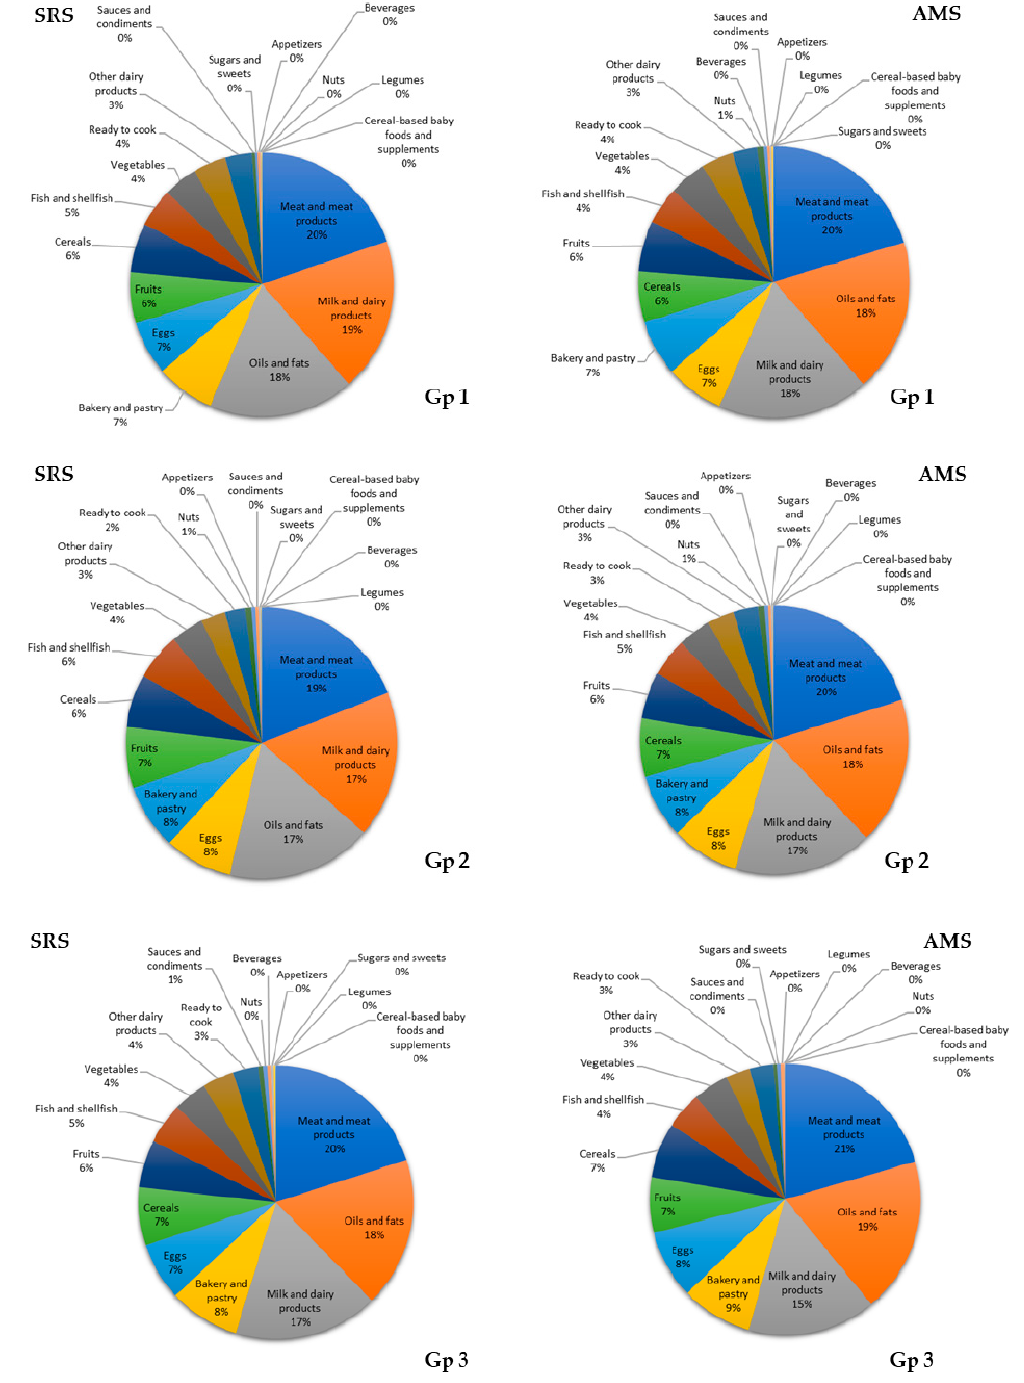
Figure 4. Contribution (%) of the 18 food groups to α -linolenic acid (ALA) intake in the EsNuPI study population (Spanish Reference Cohort (SRS) and Adapted Milk Consumers Cohort (AMS)) according to age group (( Gp 1 ), 1 to <3 years; ( Gp 2 ), 3 to <6 years; ( Gp 3 ) 6 to <10 years).